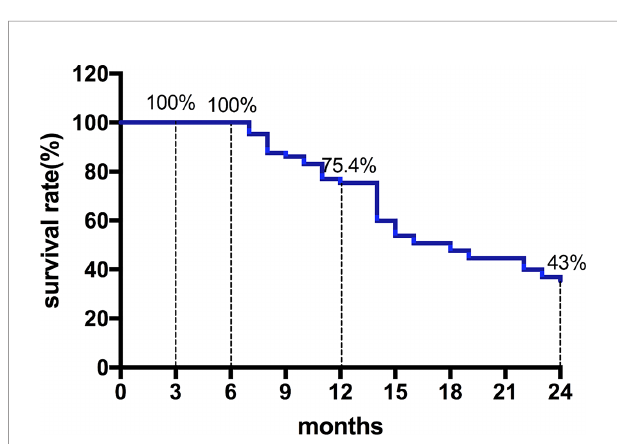
FIGURE 3 | The survival rate curve. The 3-month survival rate was 100% (65/65), the 6-month survival rate was 100% (65/65), the 1-year survival rate was 75.4% (50/65), and the 2-year survival rate was 43%